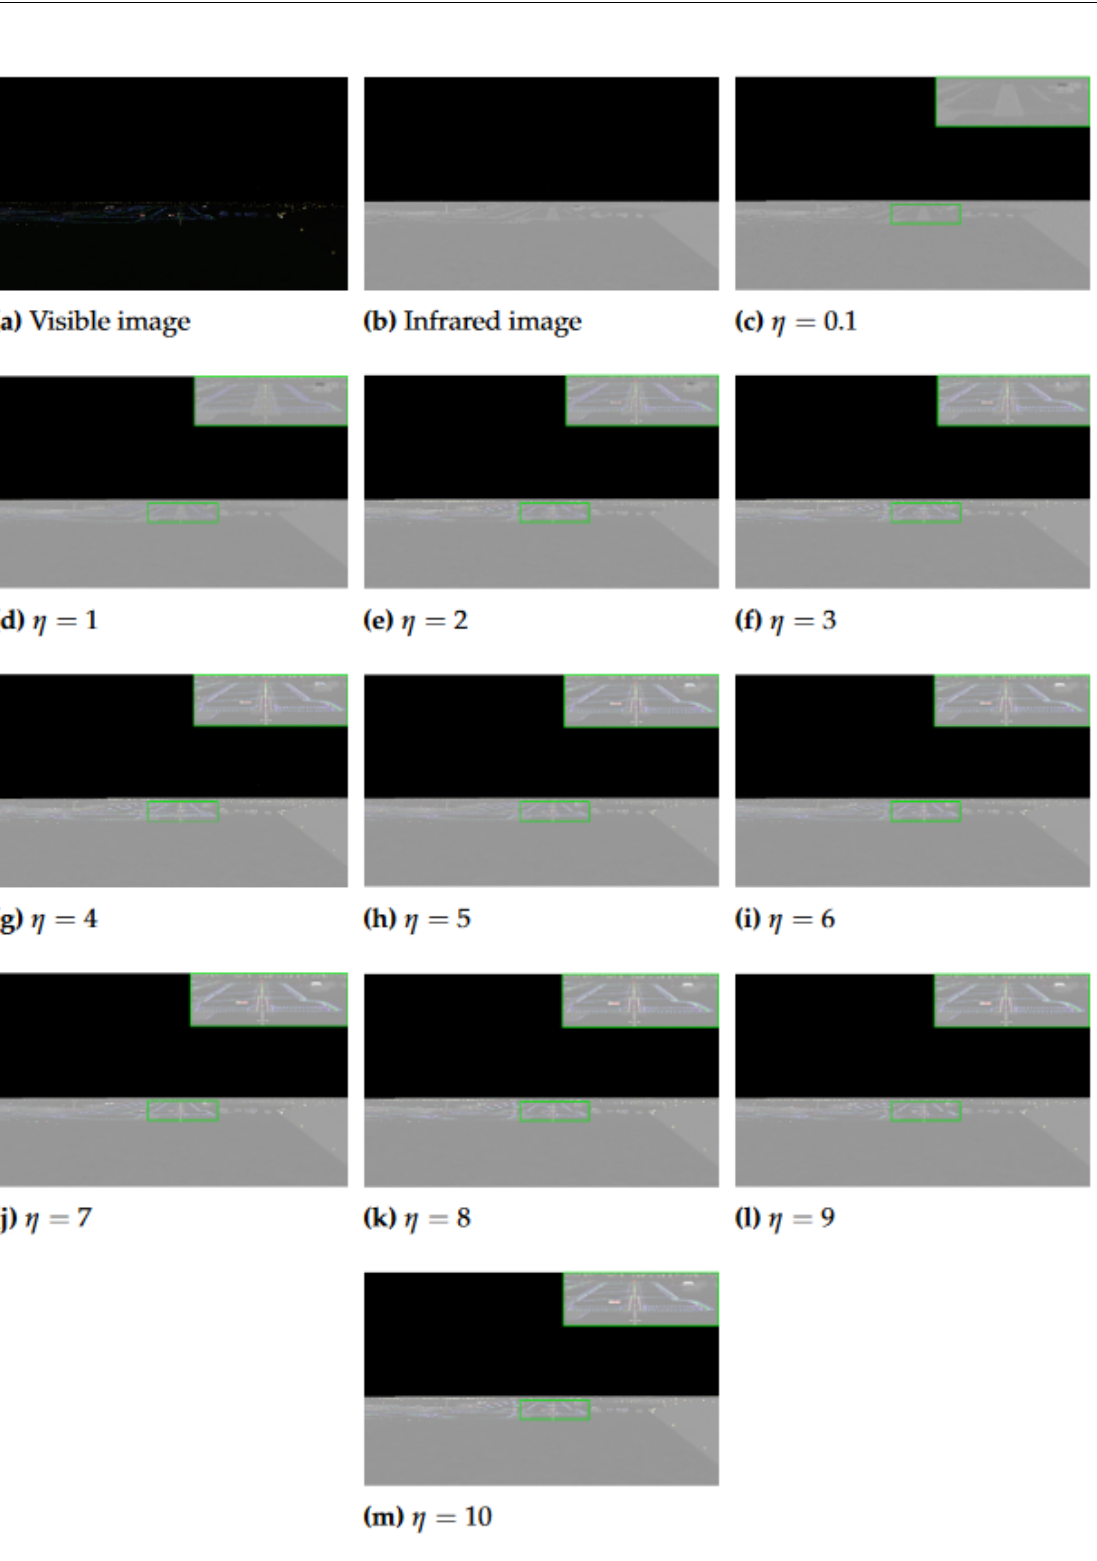
Figure 12. Fused results of Data 2 as η